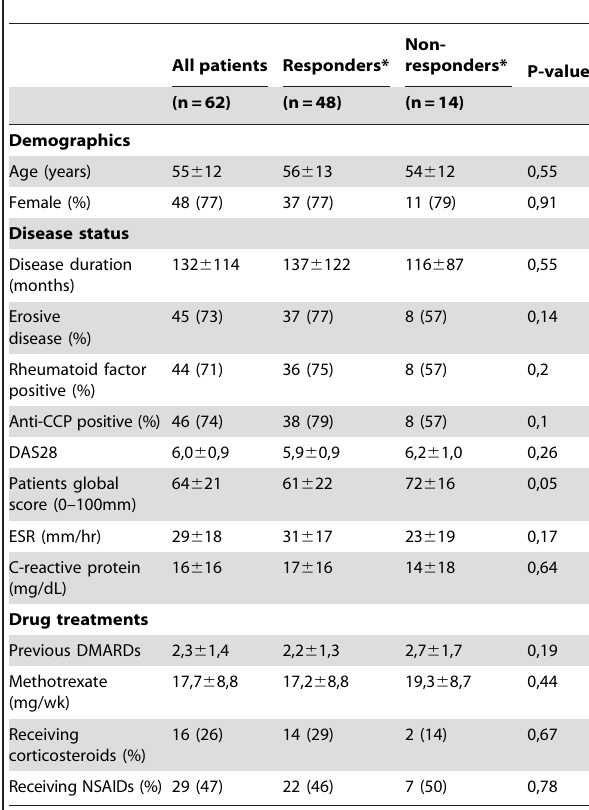
Table 1. Baseline patient